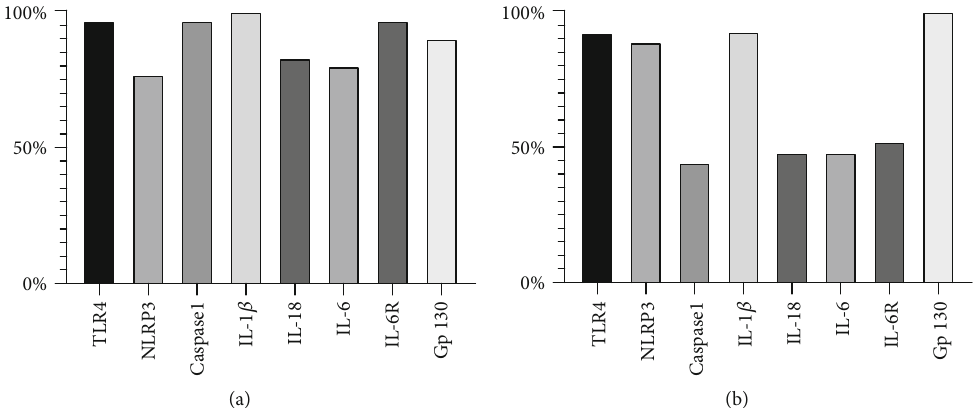
Figure 1: Genes expressed in thrombi. Percentage of thrombi with the di ff erent in fl ammasome-related marker genes expressed ((a), n = 30 ) and found by immunohistochemistry staining ((b), n = 27 ). Abbreviations: TLR4: Toll-like receptor 4; NLRP3: Nod-like receptor protein 3; IL-1 β : Interleukin 1 β ; IL-18: Interleukin 18; IL-6: Interleukin 6; IL-6R: Interleukin 6 receptor; Gp130: Glycoprotein 130. Table 2: Relation to peak troponin T. Spearman coe ffi cients of correlations (rho) between the markers measured at the time of PCI and peak troponin T. Genes in thrombus Genes in circ.